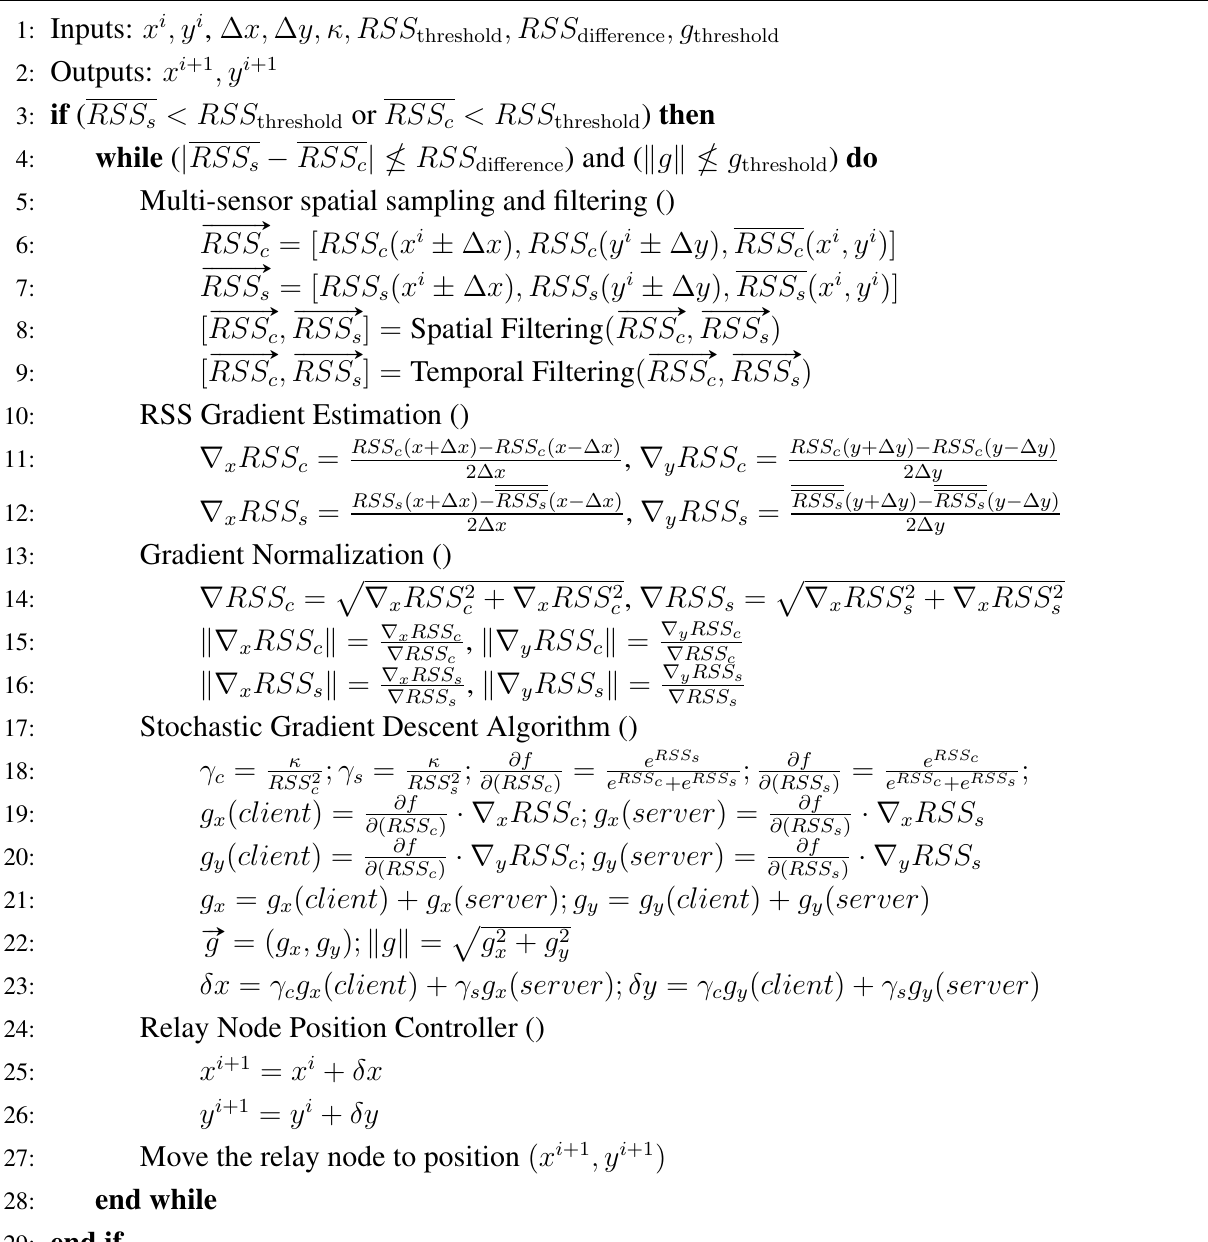
Algorithm 1 Robust stochastic optimization algorithm for RSS balancing between two wireless